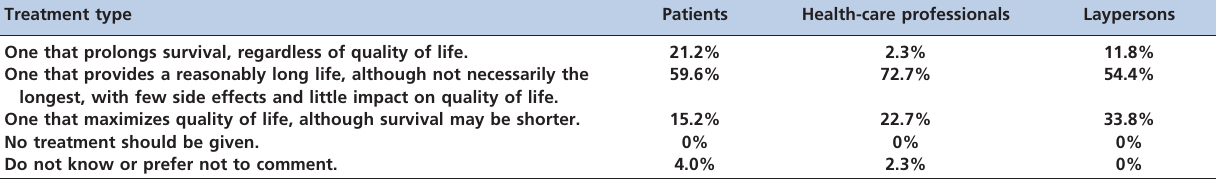
Table 2 - Priorities regarding treatment options for a fictitious cancer patient; the differences among groups were statistically significant ( p =